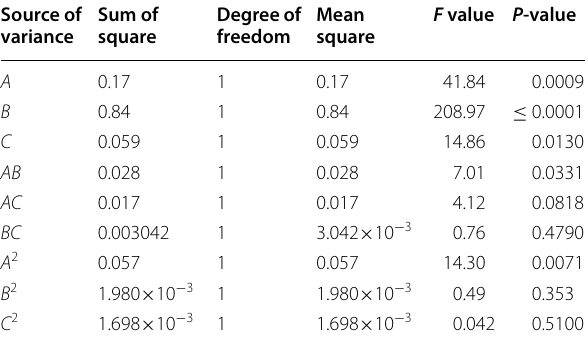
Table 8 Significance analysis of surface roughness regression model Source of Sum of variance square